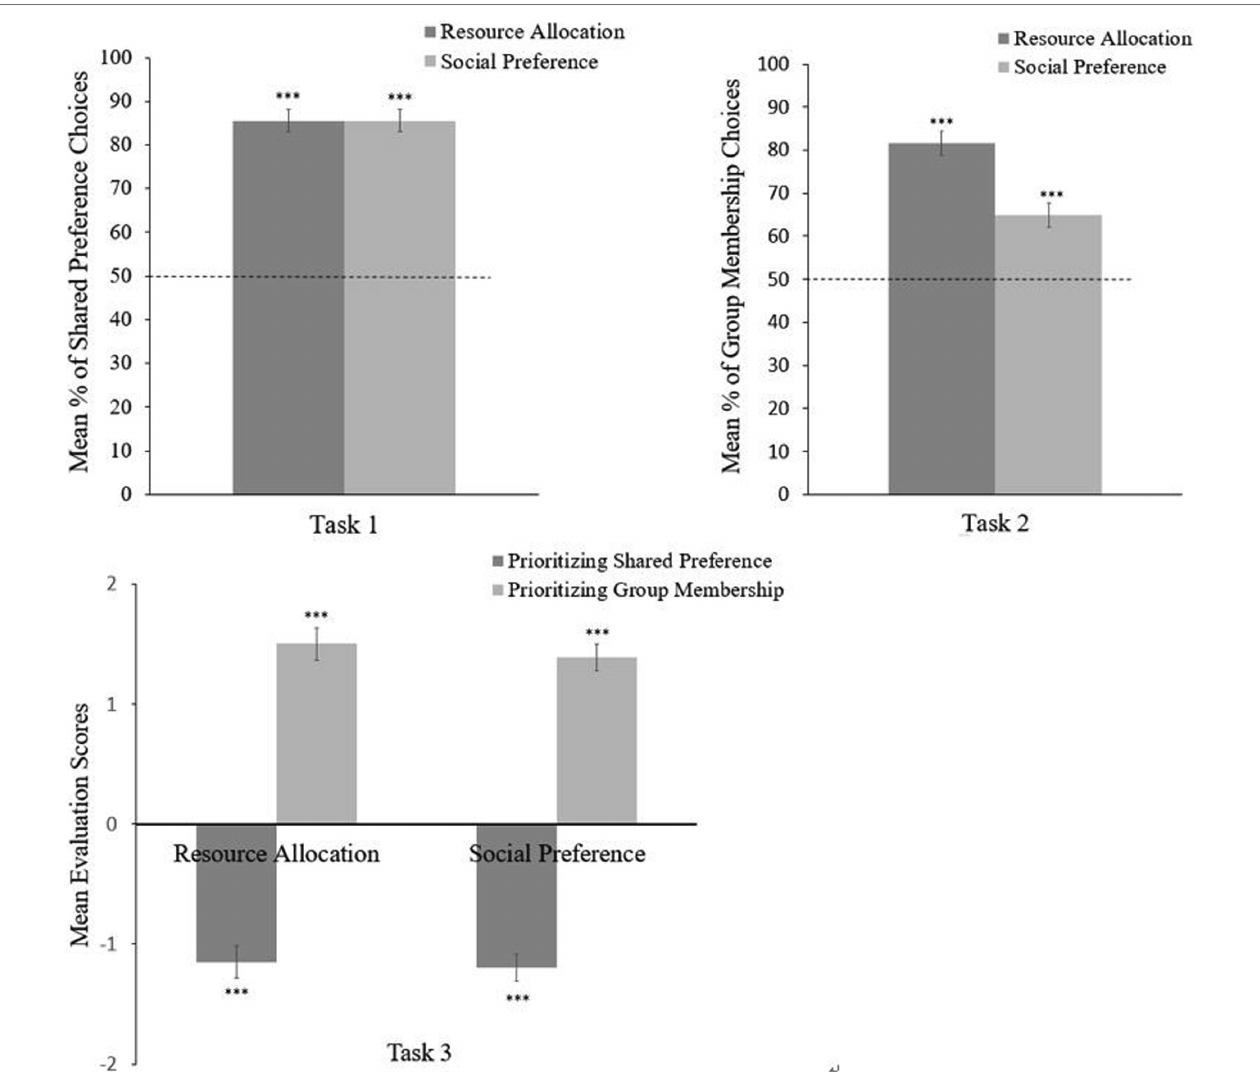
FIGURE 4 | Results of Task 1 (upper left), Task 2 (upper right), and Task 3 (bottom). Error bars depict ±1 standard error, and asterisks indicate means that are significantly different from chance ( *** p <